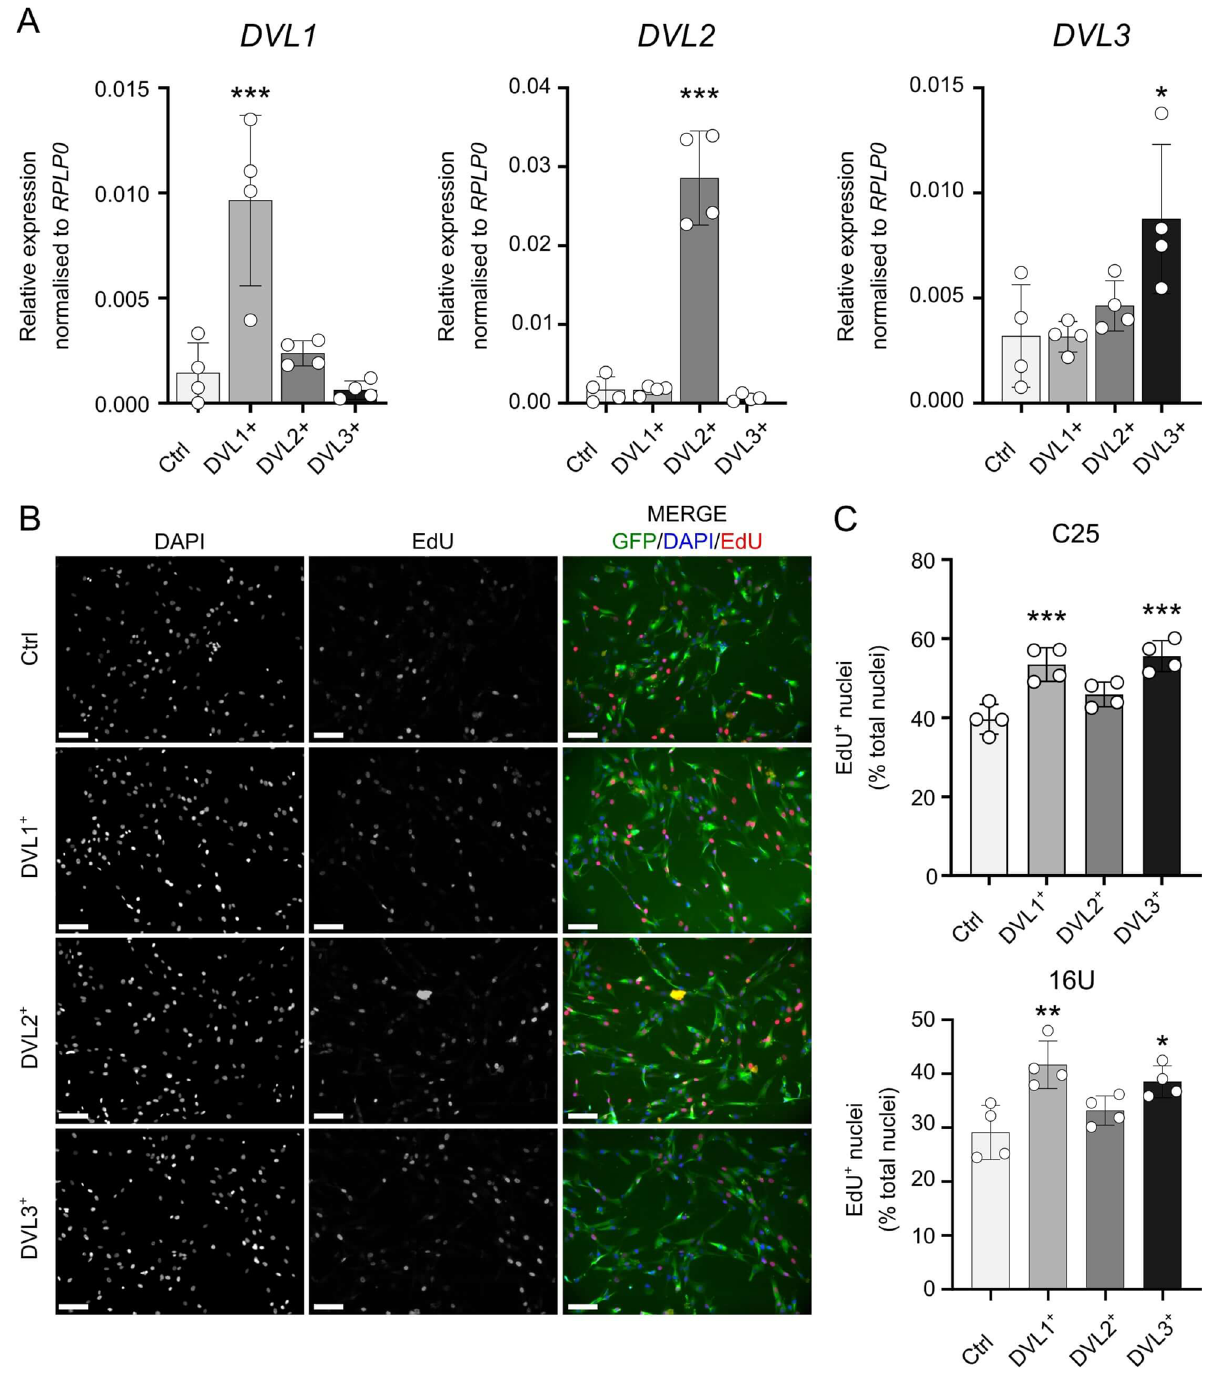
Figure 4. Constitutive overexpression of DVL1 or DVL3 enhances myoblast proliferation. ( A ) Gene expression levels of DVL1 (left), DVL2 (middle) and DVL3 (right) in proliferating human C25 DVL1 + , DVL2 + and DVL3 + myoblasts with stable lentiviral-mediated overexpression of each isoform. N = 4 biological replicates. Significant differences were calculated using a One-Way ANOVA with Dunett’s post-hoc test, comparing each group with the control (pUltra) where an asterisk denotes p < 0.05, two asterisks denote p < 0.01 and three asterisks is p < 0.001. ( B ) Representative images of proliferating C25 DVL1 + , DVL2 + or DVL3 + myoblasts overexpressing the respective DVL isoform, immunolabeled for GFP from the lentiviral backbone (indicative of DVL levels) (green), with a DAPI nuclear counterstain (blue). Myoblasts with incorporated EdU (red) are also shown, after a 2 h EdU pulse performed 24 h after seeding. Scale bar represents 100 µm. ( C ) Quantification of C25 or 16U DVL1 + , DVL2 + or DVL3 + myoblasts containing EdU as a percentage of total nuclei. More than 200 nuclei were analysed for each N = 4 biological replicate. Data is represented as mean ± SD with significant differences calculated using a One-Way ANOVA with Dunett’s post-hoc test, comparing each group with the control (pUltra), where one asterisk indicates p < 0.05, two asterisks indicate p < 0.01 and 3 asterisks p <